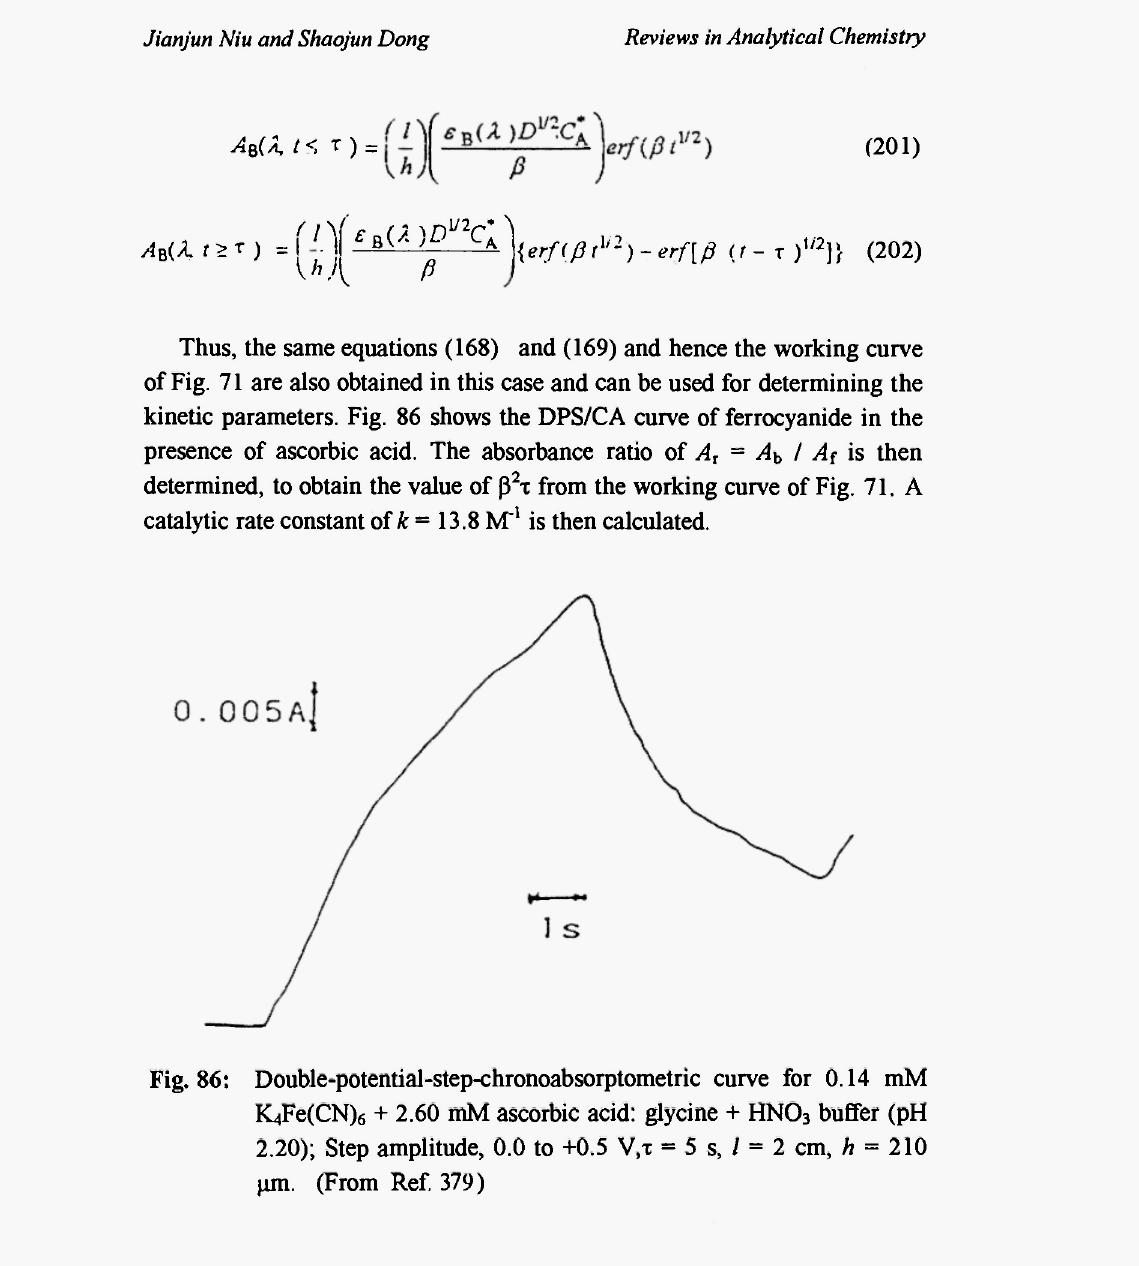
Fig. 86: Double-potential-step-chronoabsorptometric curve for 0.14 mM K4Fe(CN) + 2.60 mM ascorbic acid: glycine + HN0 6 2.20); Step amplitude, 0.0 to +0.5 V,x = 5 s, / = 2 cm, h = 210 μηι. (From Ref.